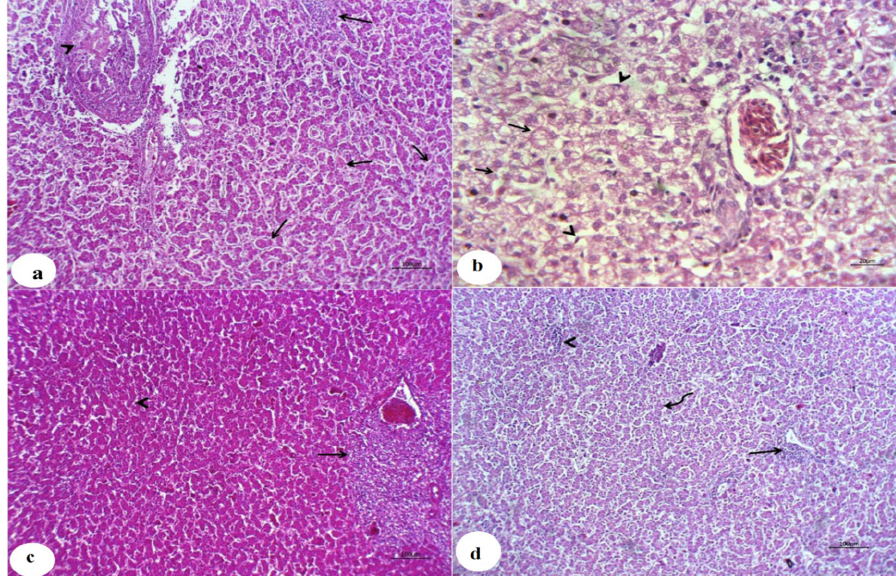
Figure 3. Photomicrographs of liver sections for chickens of all experimental groups at the end of the 3rd week. ( a ): Liver of CuSO 4 -intoxicated chicken showed hyperplastic and necrotic biliary epithelium (arrow) with various degenerative and necrotic changes in the hepatic cells (arrowhead). ( b ): Liver of CuSO 4 + Vit. C group showed moderate swelling of hepatic cells (arrow) and hyperplastic Kupffer cells (arrowhead). ( c ): Liver of CuSO 4 + Vit. E group showed lymphocytic portal aggregation (arrow) within apparently normal hepatic parenchyma (arrowhead). ( d ): Liver of CuSO 4 + Vit. C + Vit. E group showed little portal (arrow) and interstitial lymphocytic aggregations within apparently normal hepatic parenchyma (arrowhead).